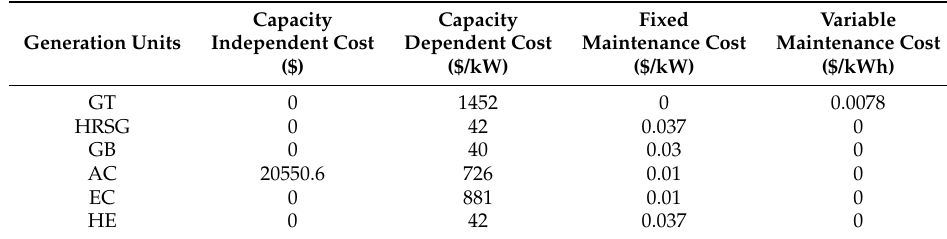
Table 3. The economic parameter settings of the GT, gas turbine; HRSG, heat recovery steam generator; GB, gas boiler; AC, absorption chiller; HE, heat exchanger.